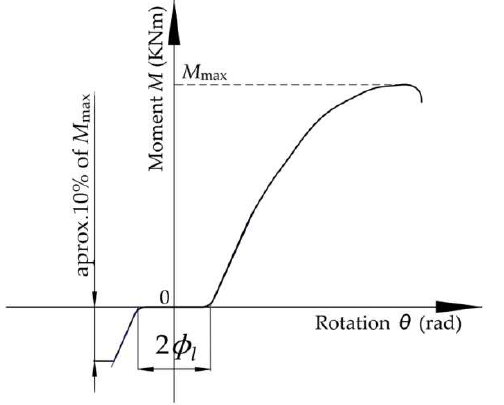
Figure 6. Typical moment rotational curve as test output to determine the looseness angle 𝛷 𝑙